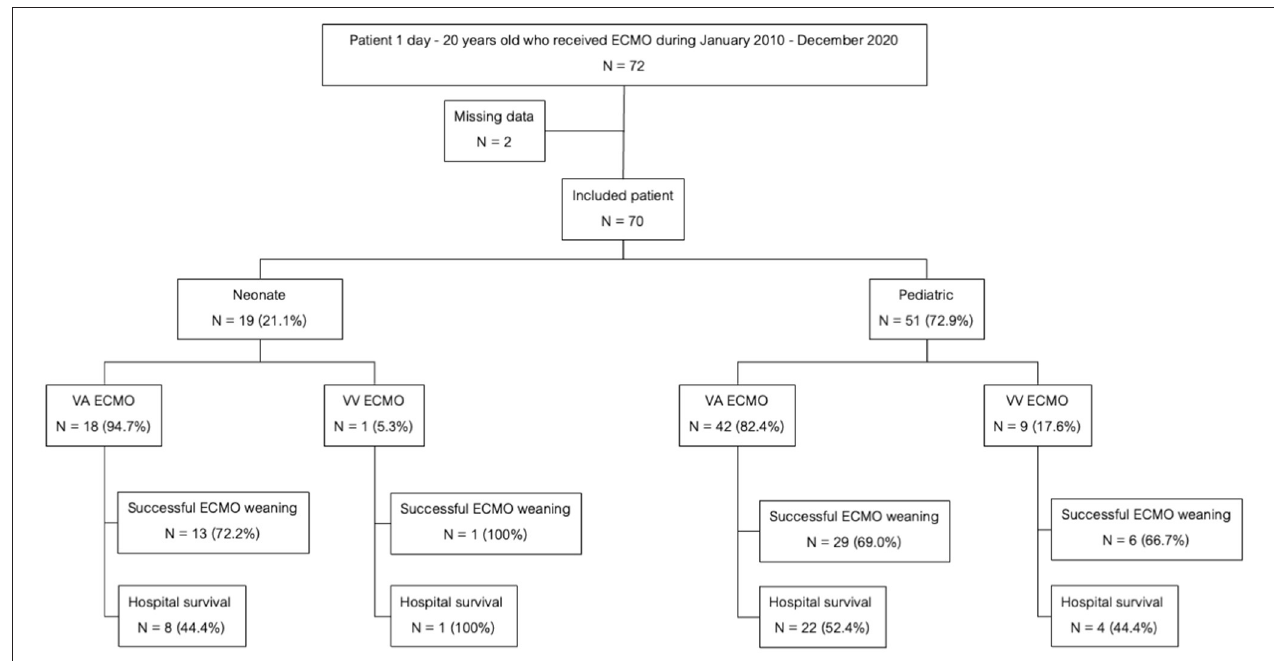
FIGURE 1 | Flow chart of pediatric ECMO patients in this